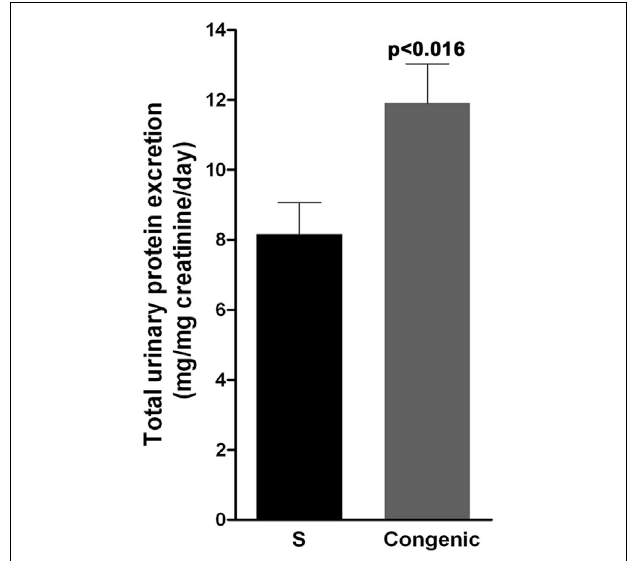
FIGURE 7 | Urinary protein excretion in S and congenic rats. Twenty-four hours urine samples were collected from S ( n = 13) and congenic ( n = 12) rats and total protein was quantitated. UPE data is presented as mg/mg creatinine over a 24-h